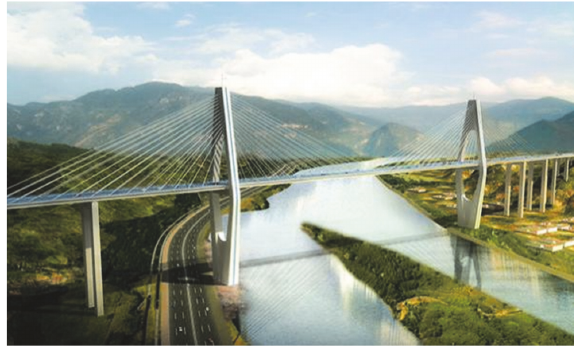
Figure 1: Xigu Yellow River